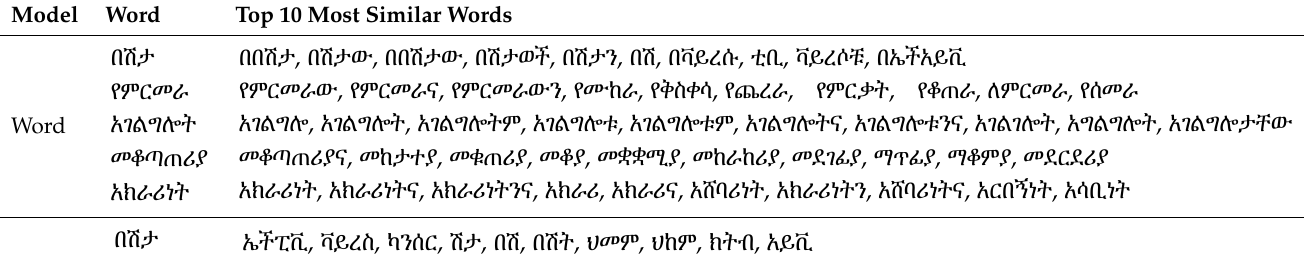
Table 10. Sample expanded terms using fastText model.